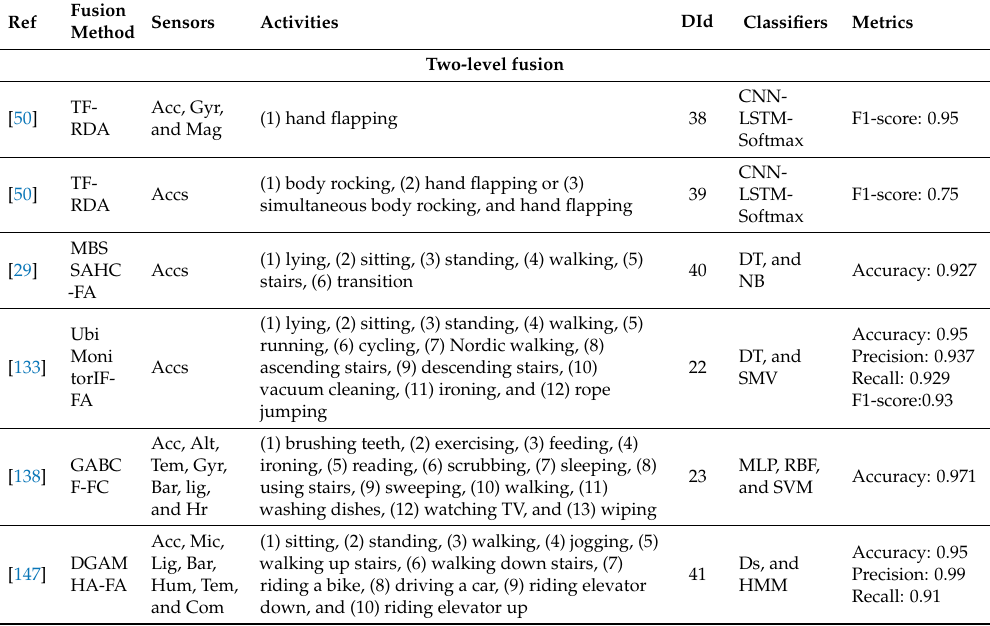
Table 11. Summary of papers that propose methods that merge data at two levels. Ref = Reference and DId = Dataset ID. Acc(s) = Acceleromter(s), Mag(s) = Magnetometer(s), Gyr(s)= Gyroscope(s), Alt = Altimeter, Tem = Temperature, Bar = Barometer, Lig = Light, Hr= Heart rate, Mic(s) = Microphone(s), Hum = Humidity, and Com =